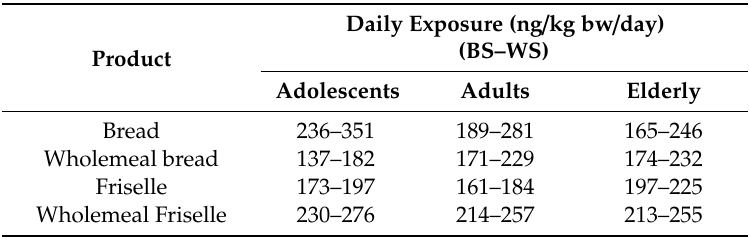
Table 5. Daily intake of acrylamide (AA) of consumers at the 95th percentile according to the two scenarios considered in this study (BS = best scenario; WS = worst